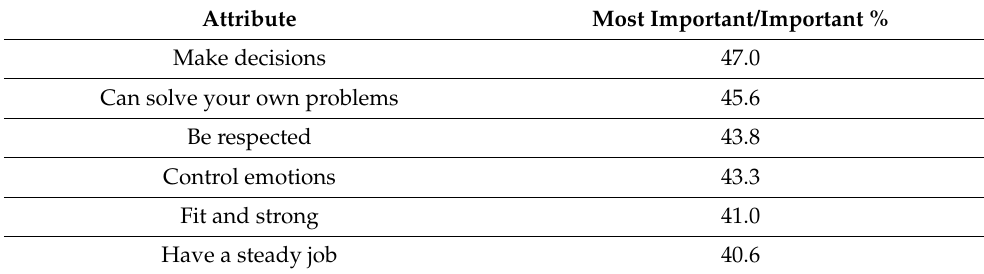
Table 3. Attributes of viable masculinity for younger men ( n =